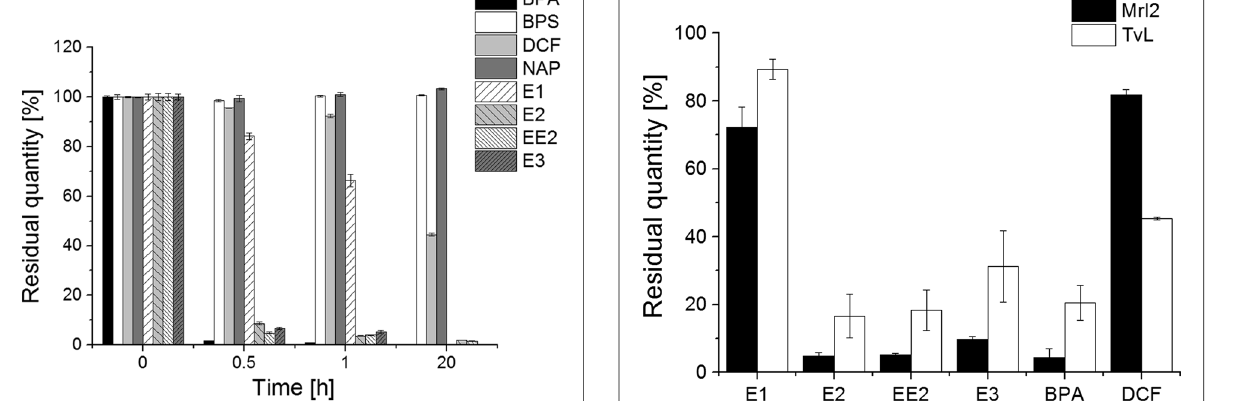
Fig. 5 Residual quantity of EDCs and NSAIDs (%) after incubation with 30 µg ml − 1 Mrl2 or TvL. The reaction time was set to 1 h except for DCF, for which it was 24 h. Measurements were carried out in